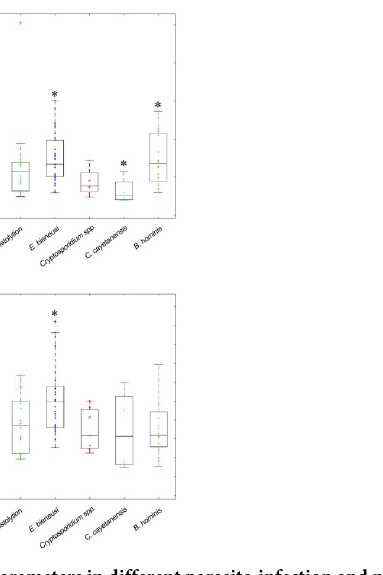
Fig 3. CD4 + T cell counts and hemogram parameters in different parasite-infection and non-infection groups of the MSM HIV/AIDS population. CD4 + T cell counts (A), WBC (B), NEUT (C) and LYMPH (D) in different parasite- infection and non-infection groups. � indicates statistical significant difference between the population with parasite infections versus the one without it.